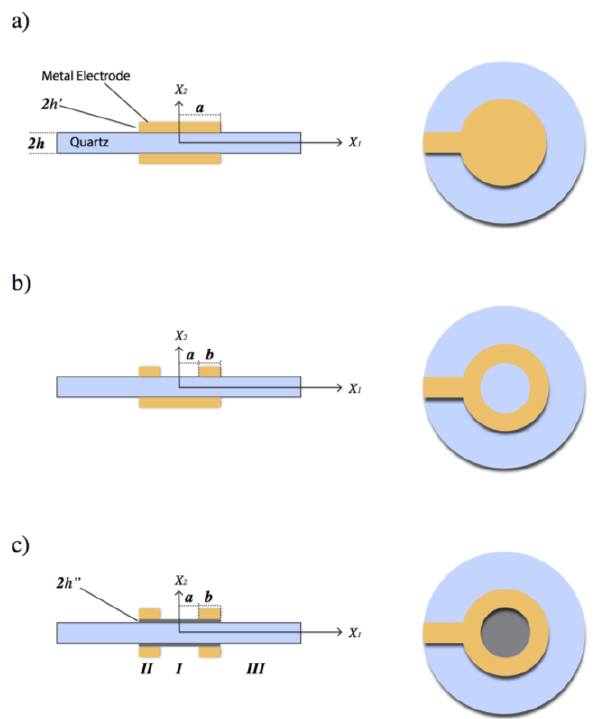
Figure 1. Cross section and front view of three QCR designs: ( a ) keyhole electrode QCR with radius a ; ( b ) ring electrode QCR with inner radius a and outer radius b ; and ( c ) modified ring electrode QCR with a first coating of solid electrodes on both sides (first layer I ) and a second coating of ring electrodes on both sides with inner radius a and outer radius b (second metal layer II ), and ( III ) non-electrode region.